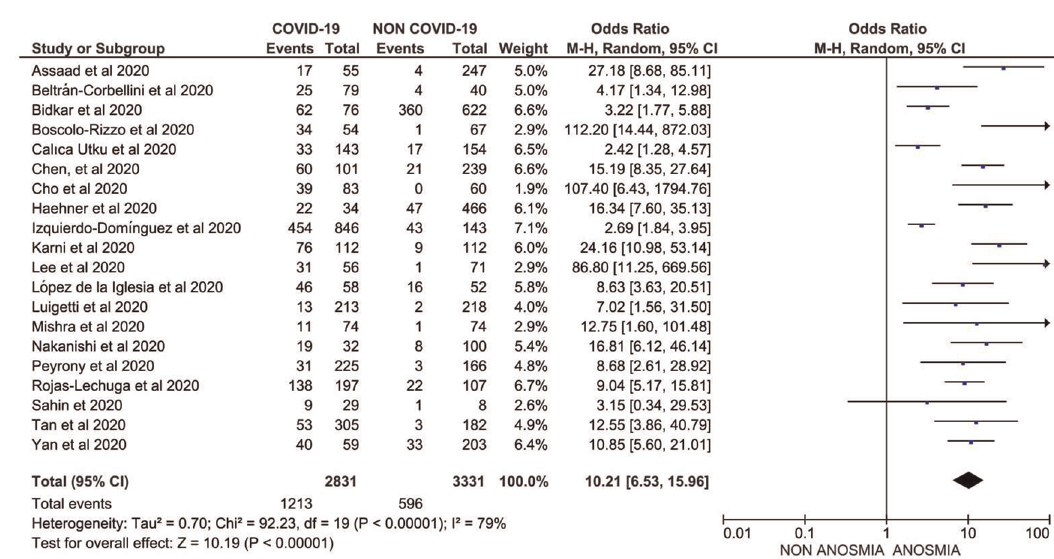
Figure 2. Forest plot of the association between anosmia and the risk of COVID-19 (OR: 10.21; 95%CI: 6.53, 15.96; p<0.001; Egger ’ p=0.8340; heterogeneity p<0.001; I-squared